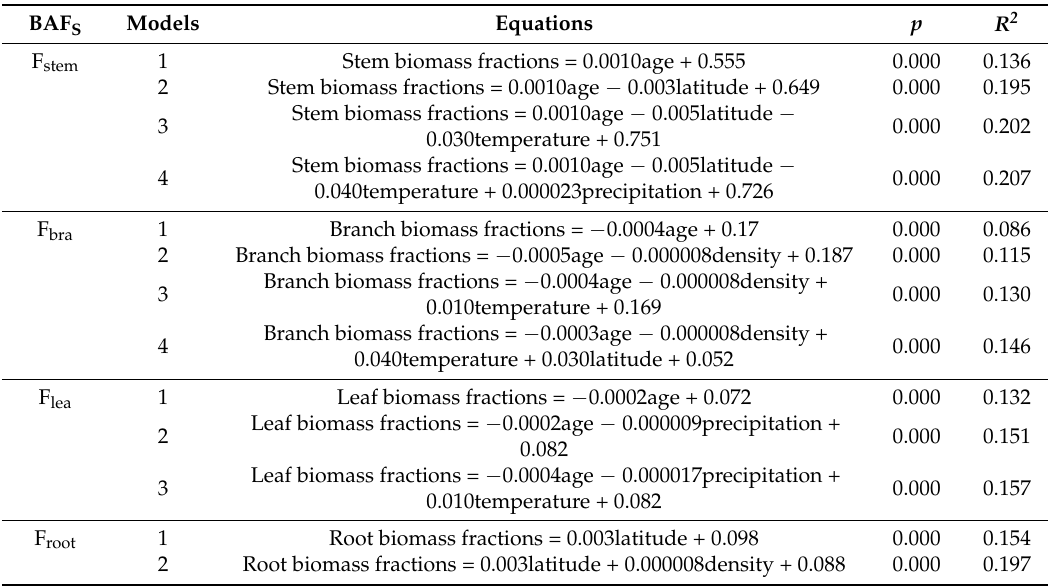
Table 4. Stepwise multiple regressions (SMR) between four biomass allocation fractions (BAFs) with stand characteristics and environmental factors in China’s